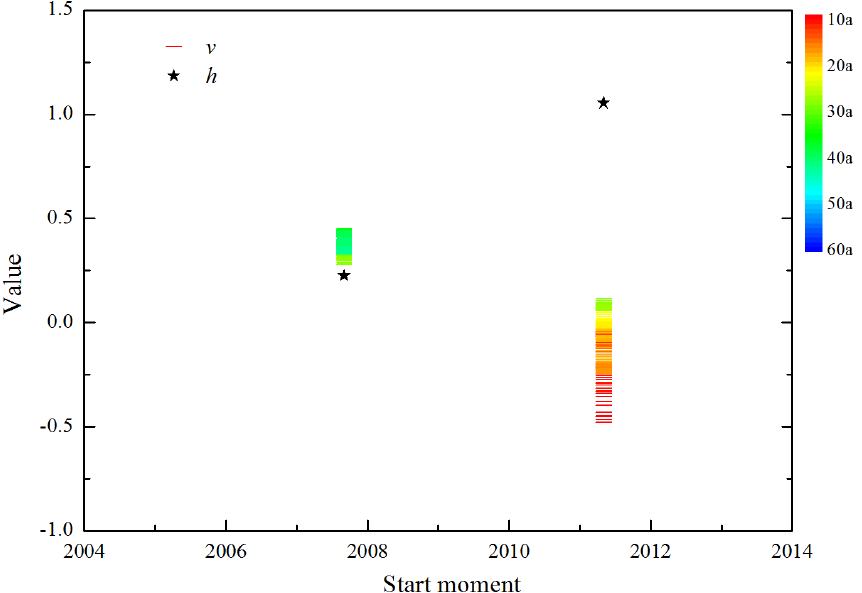
Figure 9. The values of the parameters v and k of two transition processes with different lengths of the subsequence. The black stars represent the values of parameter h , and the colorful short bars represent the values of parameter v . The colored bar represents years of the subsequence length from 10 to 60 in intervals of